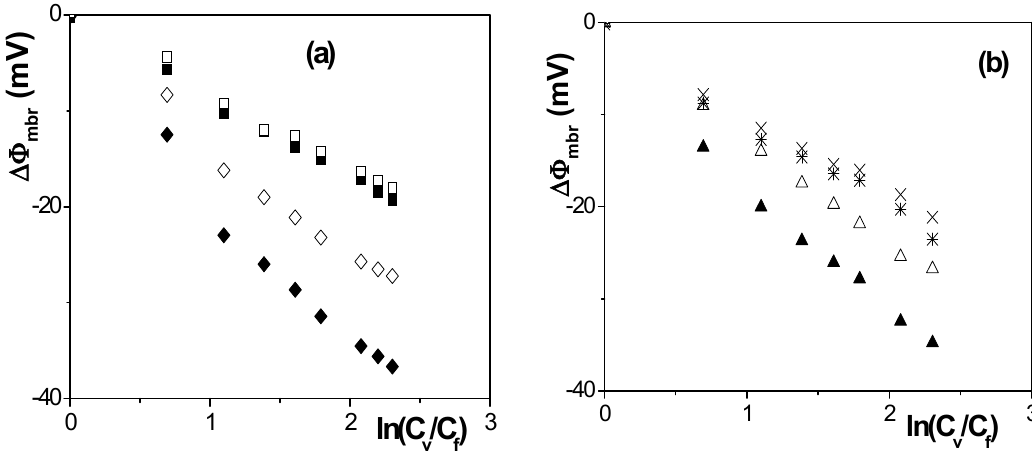
Figure 5. Membrane potential as a function of solution concentrations ratio measured with: ( a ) stirred solutions, Anopore (■), Al-Sf (♦), and non-stirred solutions, Anopore (□), Al-Sf (◊); and ( b ) stirred solutions, Al-Ox/Al O (▲), Al-Ox/SiO (*), and non-stirred 2 3 2 solutions, Al-Ox/Al O (∆), Al-Ox/SiO 2 3 2